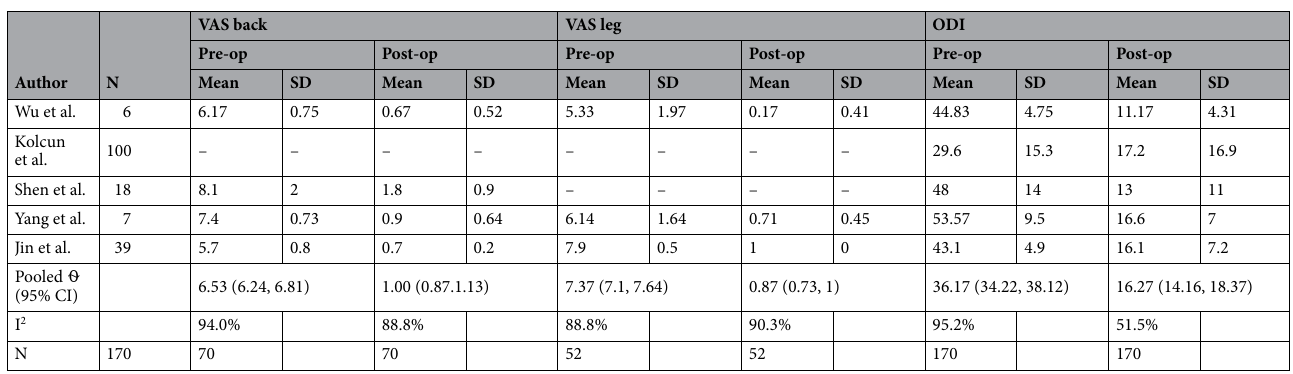
Table 5. Estimation of the pooled means for clinical outcomes in iLIF